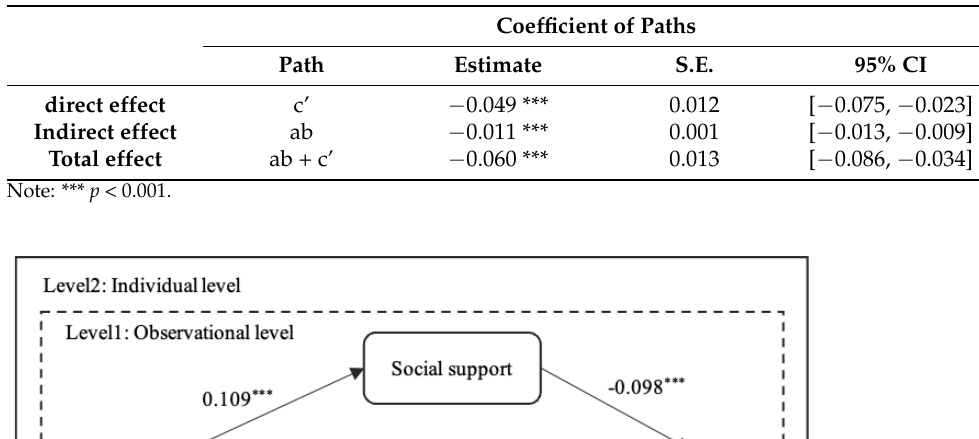
Table 6. Significance test results of mediating effect of social support.